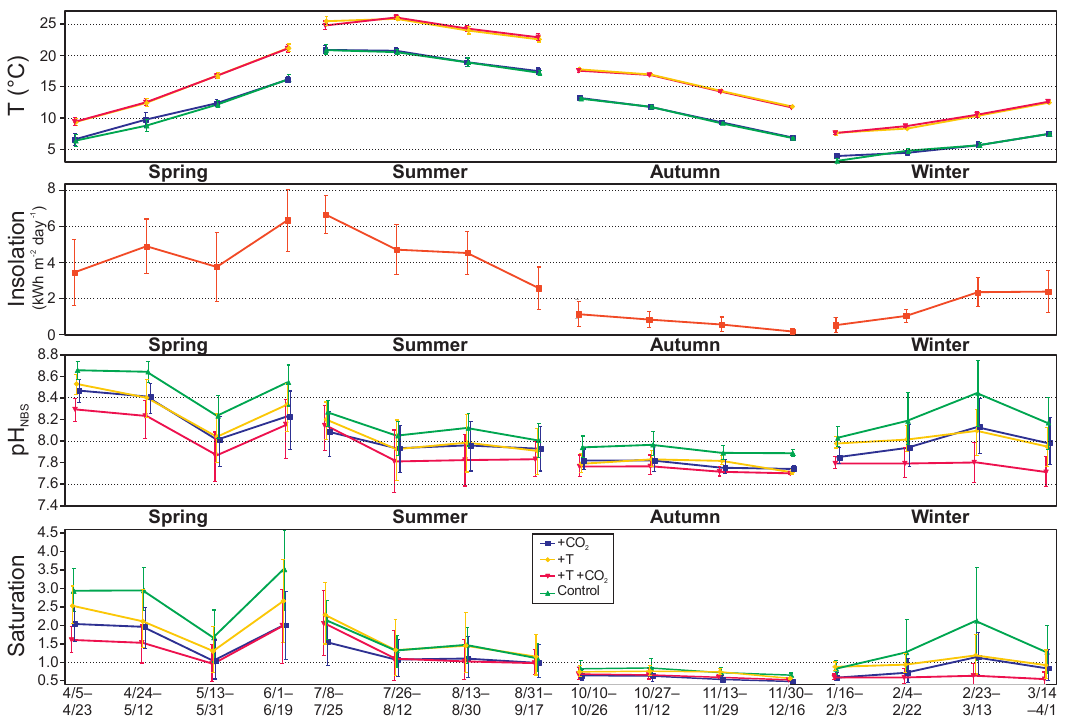
Figure 3. Average water temperature, daily insolation, pH and saturation state with respect to aragonite (as proxy for S. spirorbis Mg-calcite) in the four different treatments. Each of the four seasonal experiments is divided into four sub-periods lasting 17–19 days (start and end dates indicated at x axis). Error bars indicate minimum and maximum values of the mean diurnal cycle during the sub-periods, except for insolation where they indicate day-to-day variability (standard deviation). Insolation was measured at the GEOMAR meteorological observatory (www.geomar.de/service/wetter), about 100m from the benthocosms.